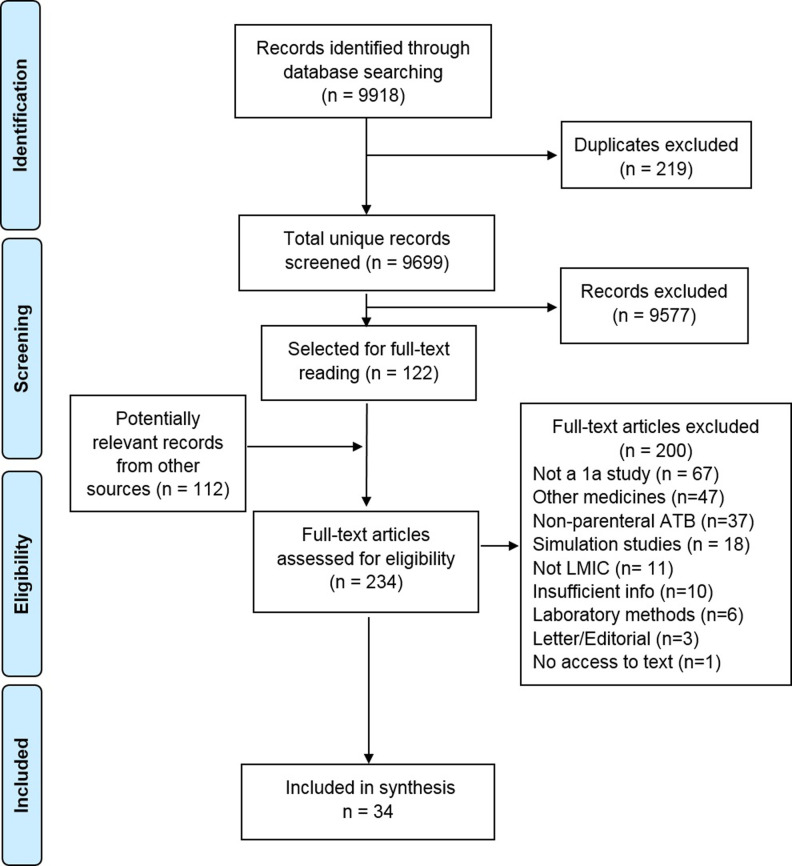
Flow chart of the process of study identification and selection.ATB: antibiotics, LMIC: Low- and middle-income countries.